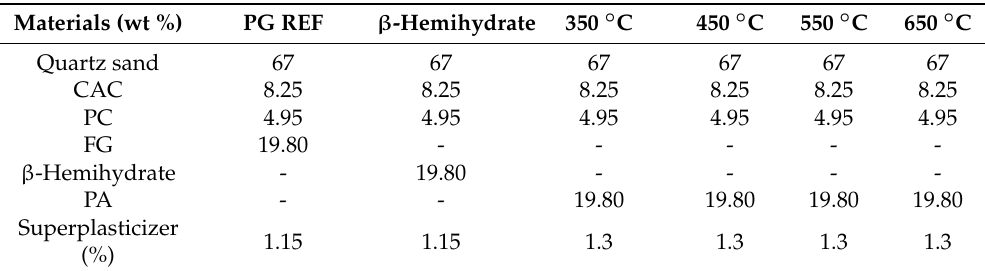
Table 4. Percentage of raw materials in SLU